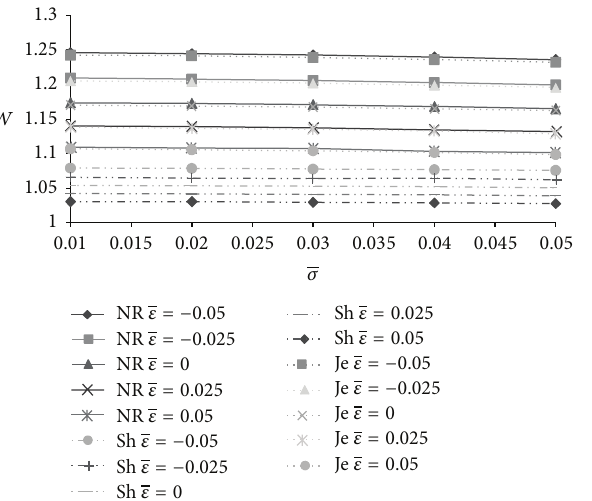
Figure 7: Variation of load carrying capacity with respect to 𝜎 and 𝜀 .